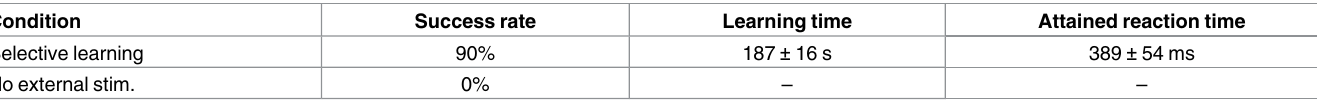
Table 1. Statistical performance of the